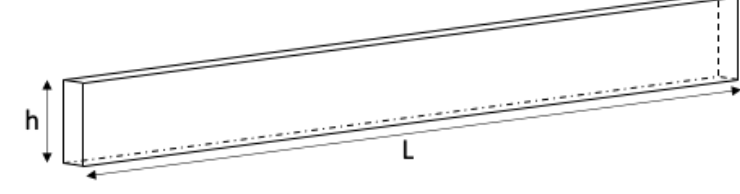
Figure 1. Simple 2D domain used for grid independence